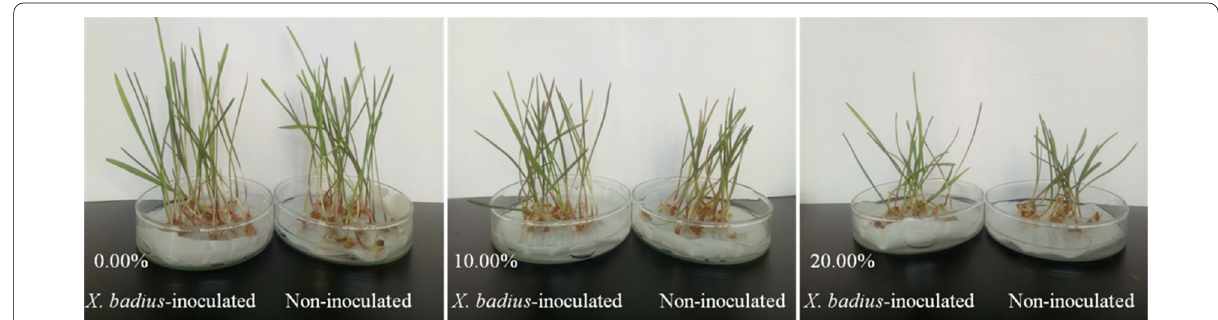
Fig. 2 Typical phenotype of L. multiflorum Lam. seedlings 2 weeks after inoculation or non-inoculation with X. badius under different PEG-6000-induced drought